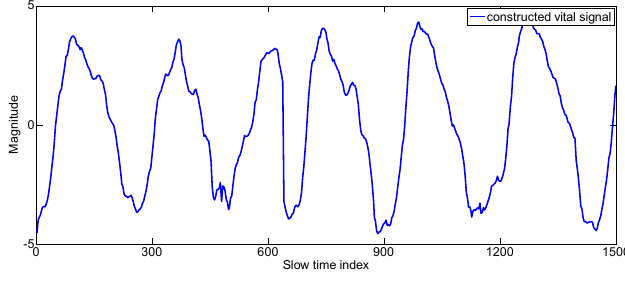
Figure 10. The final constructed vital signal.